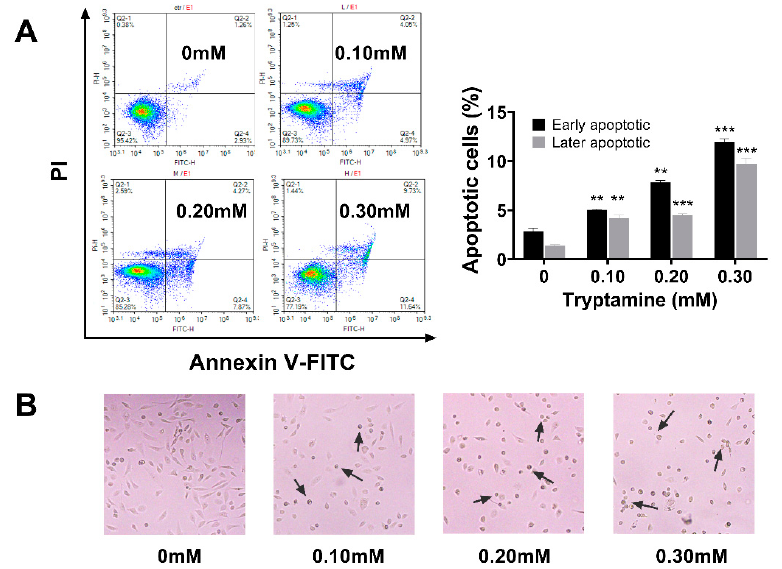
Figure 5. Tryptamine-induced PC-3 cell apoptosis. ( A ) Apoptosis of PC-3 cells was examined by Annexin V-FITC/PI staining and analyzed by flow cytometry after incubating with tryptamine un-